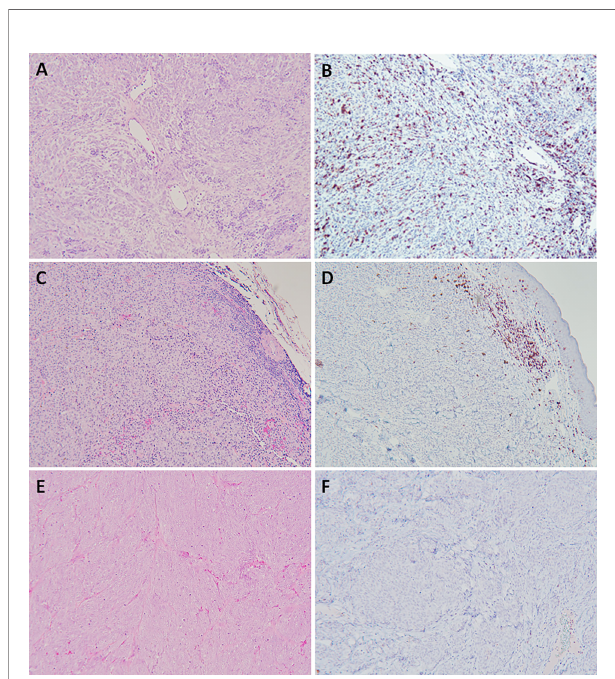
FIGURE 1 | Naturally arising canine oral malignant melanoma with differences in immune pro fi les hallmarked by vastly differing quantity and spatial distribution of cellular in fi ltrates (H&E), and speci fi cally CD3 + T lymphocytes (IHC, nova red chromogen). Representations of immune-in fl amed (A, B) , immune-excluded (C, D) , and immune-desert (E, F) . Magni fi cation